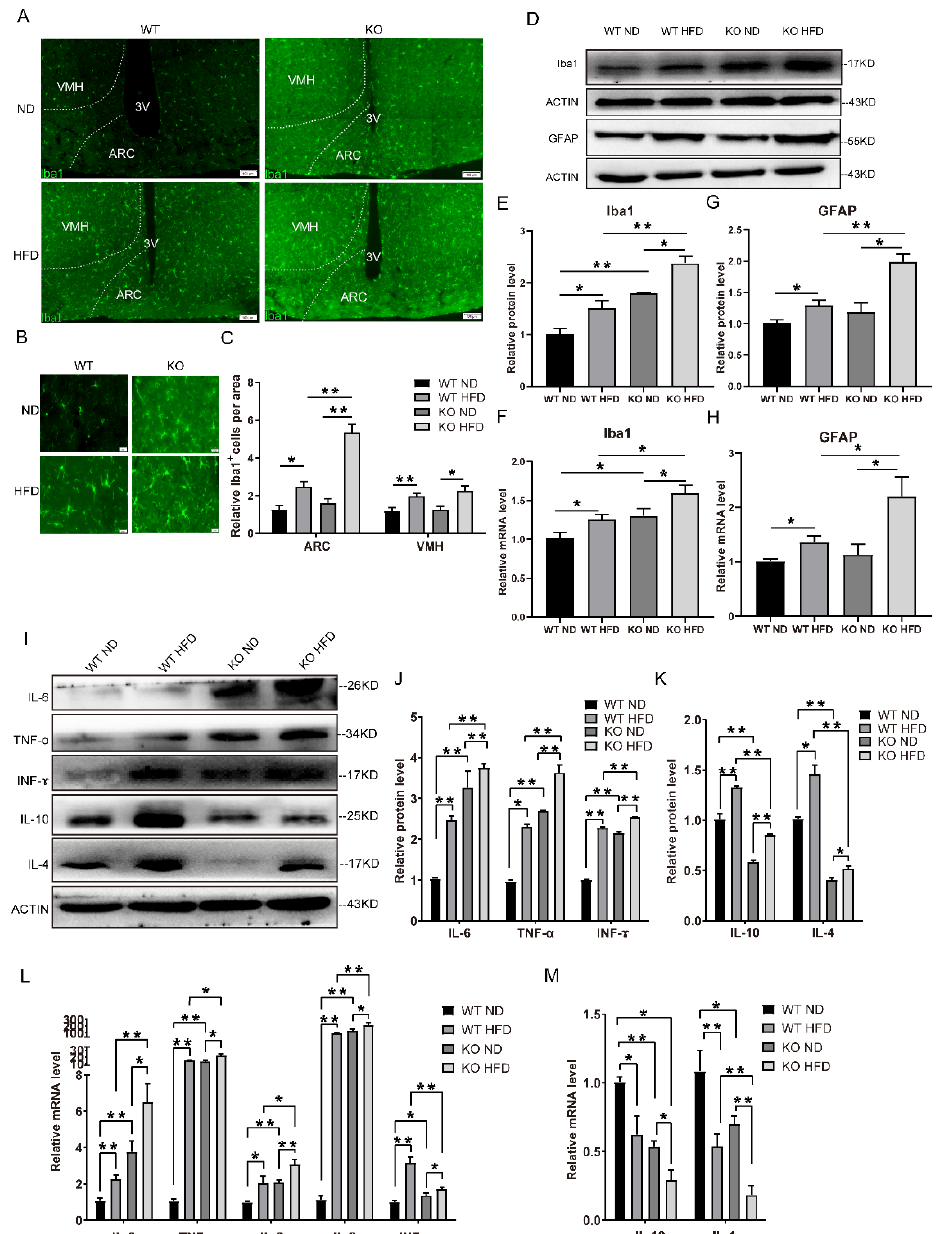
Figure 5. TRIM67 deletion increases hypothalamic inflammation in HFD mice. ( A ) The immunostaining of Iba1 in hypothalamus from four groups and imaging by Olympus software ( n = 3). ( B ) The magnified images of the ARC region ( n = 3). ( C ) The quantity of Iba1-positive cells in the ARC region ( n = 3). ( D ) The protein levels in hypothalamus of Iba1 and GFAP were assayed by Western blots ( n = 3). ( E ) The gray value statistical analysis of Iba1 ( n = 3). ( F ) The mRNA level of Iba1 was assayed by RT-qPCR ( n = 4). ( G ) The gray value statistical analysis of GFAP ( n = 3). ( H ) The mRNA level of GFAP was assayed by RT-qPCR ( n = 4). ( I ) The protein levels in hypothalamus of pro-inflammatory factors and anti-inflammatory factors were assayed by Western blots ( n = 3). ( J ) The gray value statistical analysis of IL-6, TNF- α , and IFN- γ , respectively ( n = 3). ( K ) The gray value statistical analysis of IL-10 and IL-4 ( n = 3). ( L ) The mRNA levels of pro-inflammatory factors in hypothalamus ( n = 4). ( M ) The mRNA levels of anti-inflammatory factors in hypothalamus ( n = 4). Four samples from each group were used for RT-qPCR analysis and two duplicate samples were measured. The data are presented as means ± SEM. * p -value < 0.05; ** p -value < 0.01.